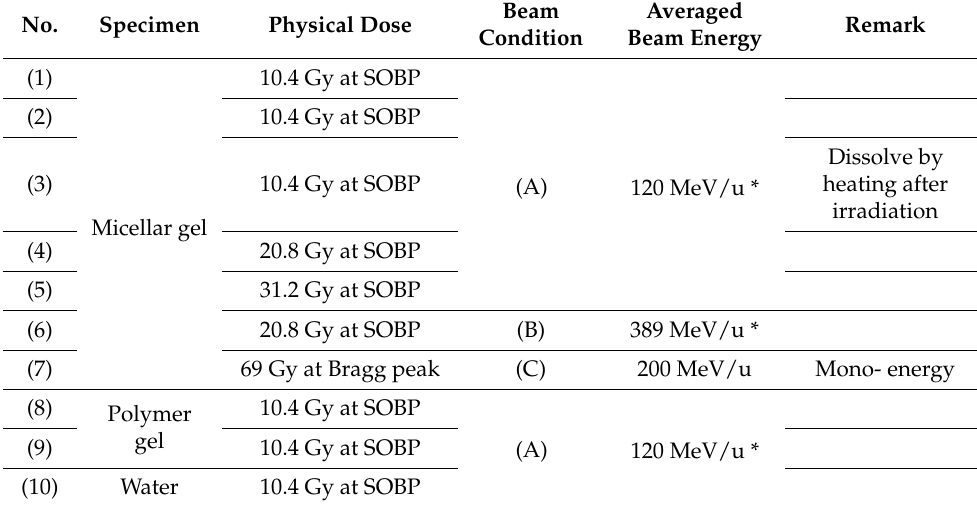
Table 2. Experimental conditions.